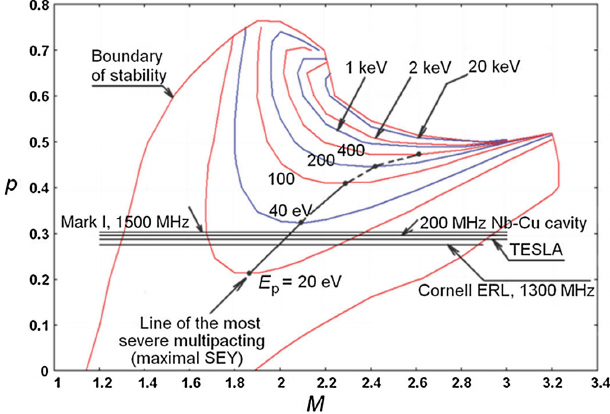
FIG. 12. Equatorial cross-field multipacting zone of the first order.